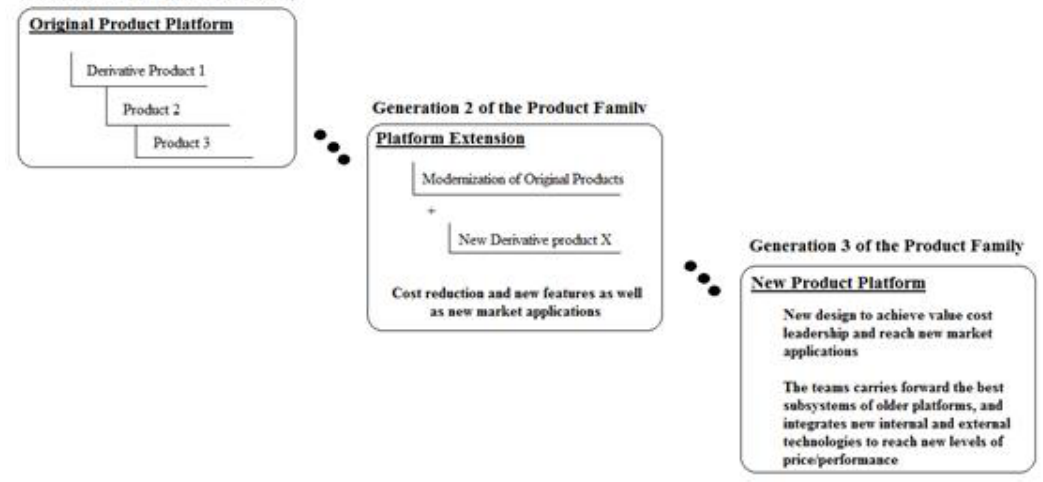
Figure 2. Product family evolution and platform renewal (Modified; Meyer & Lehnerd, 1997, p.